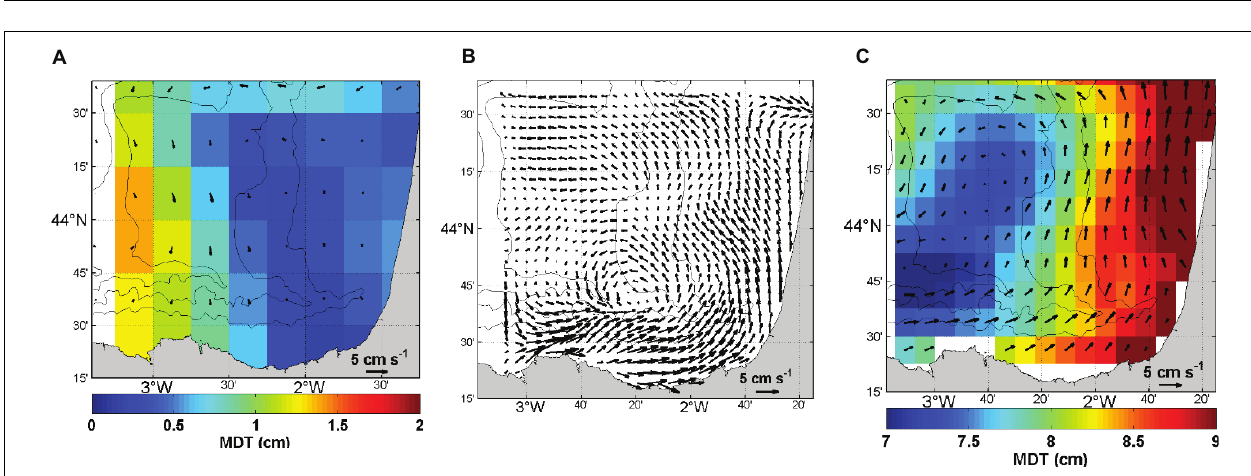
FIGURE 2 | (A) CNES-CLS13 MDT referenced to 1993–2012 and derived geostrophic vectors, (B) HF radar-derived surface mean current velocity vectors over 2009–2017, and (C) CNES-CLS18 MDT referenced to 1993–2012 and derived geostrophic